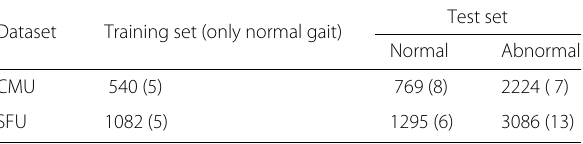
Table 5 Number of frames and walking sequences in additional datasets Dataset